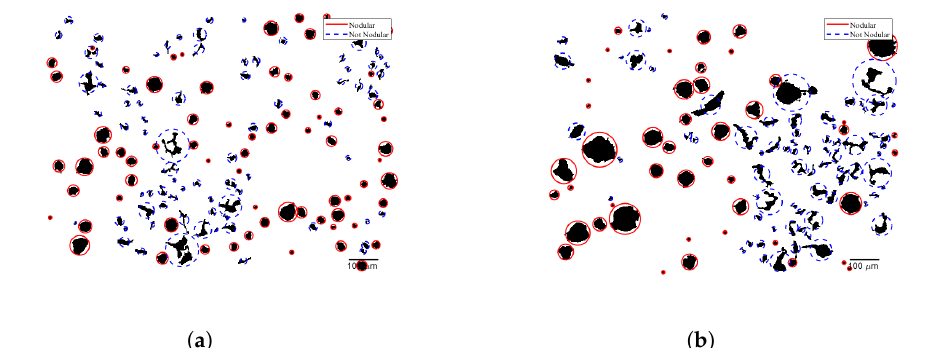
Figure 19. Computational image identification on GGG60. ( a ) GGG60-1. ( b )